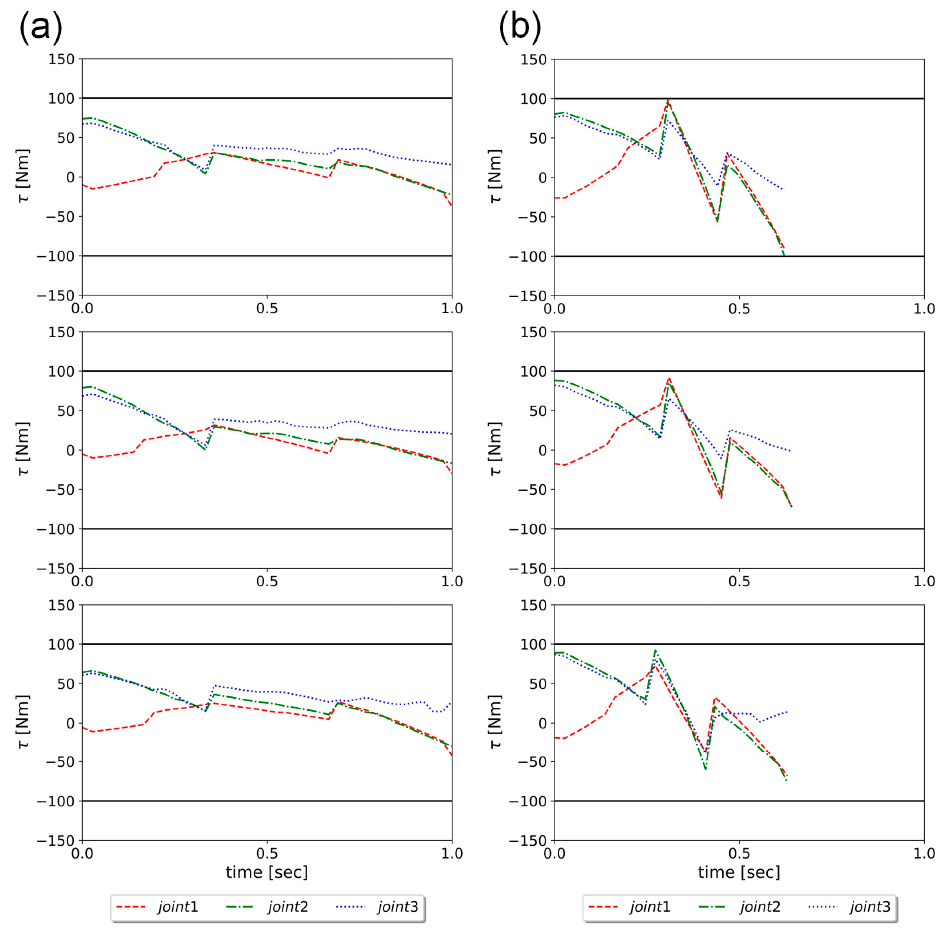
Figure 11. The joint torque profiles of the model ( a ) before and ( b ) after speed optimization. The rows represent three different trials. The black solid lines represent the torque limits.